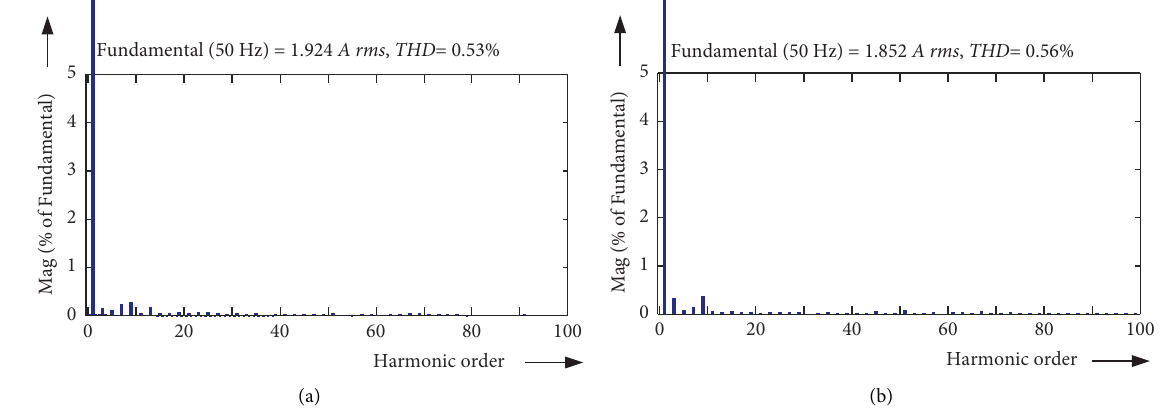
Figure 17: FFT spectra of load current at M � 1.0. (a) SVPWM-I. (b) SVPWM-II.